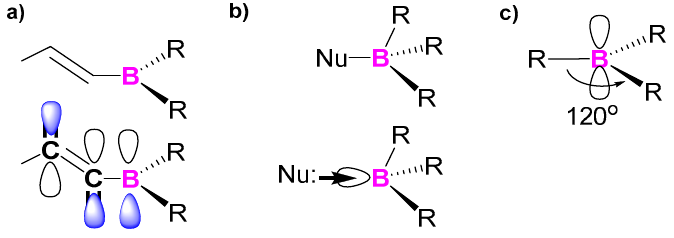
Figure 2. Three essential characteristic properties of boron atom for the molecular designs of new π -conjugated materials: ( a ) p π - π * conjugation; ( b ) Lewis acidity; and ( c ) trigonal planar geometry.